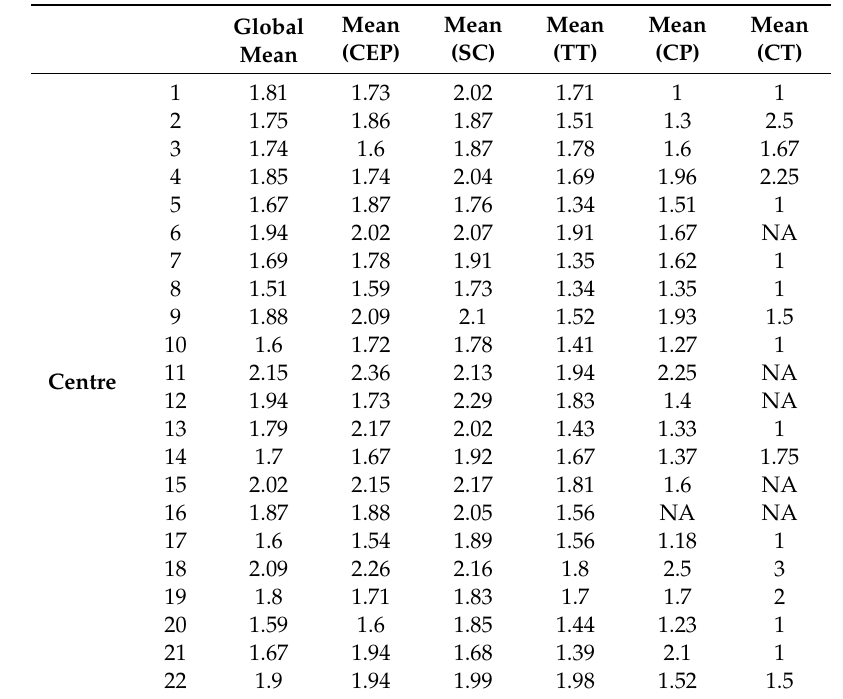
Table 4. Mean Global Assessment of Secondary Education High Schools (SEHS) as healthy-eating promoters and by study